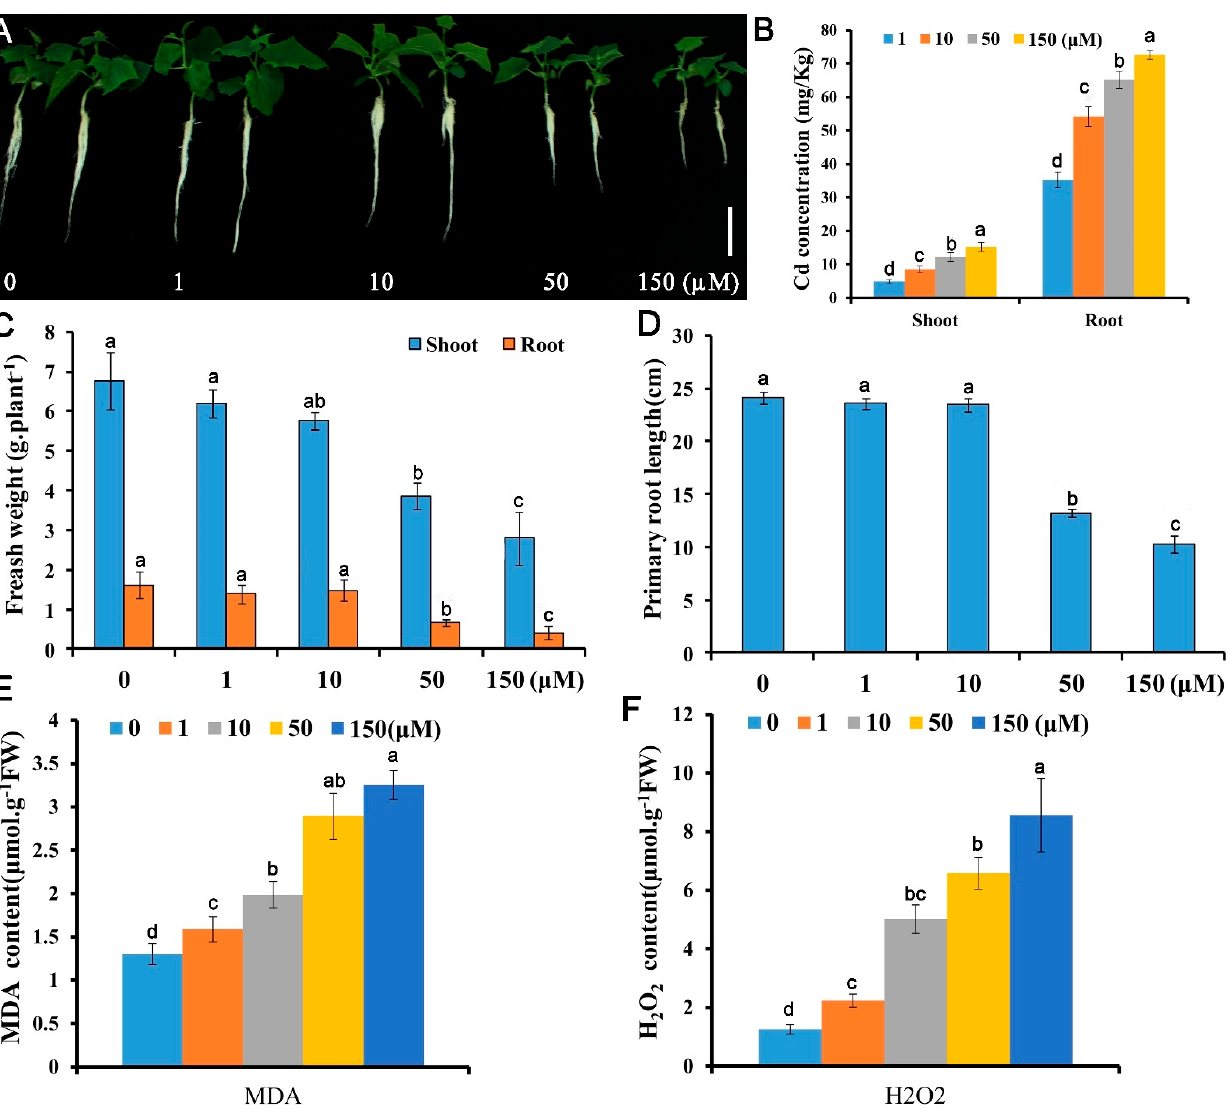
Figure 1. Growth and physiological responses of Cucumis sativus L. to Cd stress. Ten-day-old seedlings were treated with 0, 1, 10, 50, or 150 µ M CdSO4 for 10 d ( A – D ) or 48 h ( E , F ) and growth and physiological indices were assessed: ( A ) morphology; ( B ) Cd content; ( C ) fresh weight; ( D ) primary root elongation; ( E ) MDA content; ( F ) H 2 O 2 content. Vertical bars represent standard deviation of the mean of three replicates ( n = 10–20 seedlings). Significance of differences between the treatments was statistically evaluated by analysis of variance (ANOVA). Different letters on the bars indicate significant difference ( p < 0.05) between the treatments.